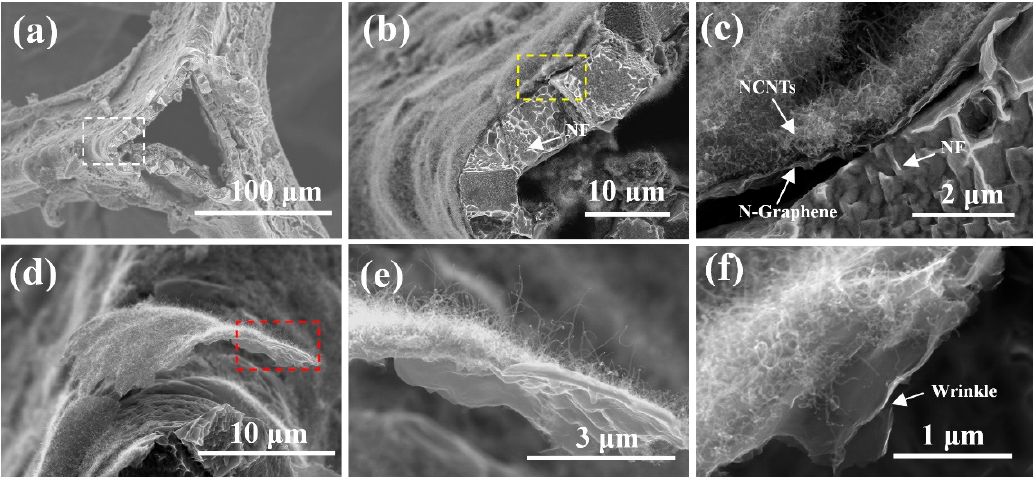
Figure 3. ( a ) SEM image of the top view of a triangle fracture plane of NF; ( b , c ) the high magnification of the edge of the fracture plane of NF; ( d ) A flake composed of N-CNTs/N-graphene cocked from the surface of NF; ( e , f ) The high magnification SEM images of flake.